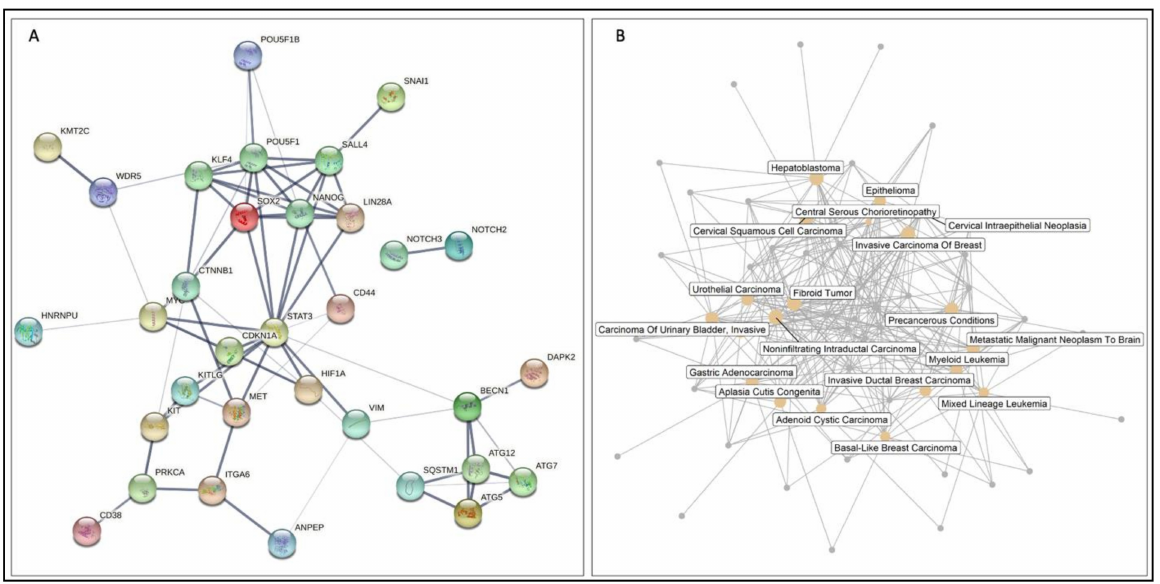
Figure 5. Functional and physical protein–protein interactions and DisGeNat analysis. ( A ) Physical and functional protein– protein interactions in the subset of genes that were reviewed in this work obtained using the STRING database v11.04. Nodes represent proteins, while the thickness of edges indicates the strength of the data obtained from a modified naïve Bayes algorithm. The evidence underlying the network was restricted to interactions in humans that were derived from curated databases (Biogrid), in addition to physical experiments, and co-expression (excluding text-mining, predicted, and orthologous evidence); 51 nodes, 70 interactions, 15 expected interactions, p -Value < 10 − 16 . ( B ) A network generated by DisGeNet, depicting common diseases for which the network of genes was enriched. This information was obtained from the DisGeNet databases, using the ClusterProfiler package in R. The comparison includes a subset of 47 protein-coding genes discussed in this review that were curated in the DisGeNet database. The top 20 most enriched diseases were labelled, with the size of their corresponding gold node representing the adjusted − log10 p -Value of enrichment, while unlabelled grey nodes represent genes implicated in these cancer states. In total, 191 disease states were enriched (Bonferroni corrected p -Value <